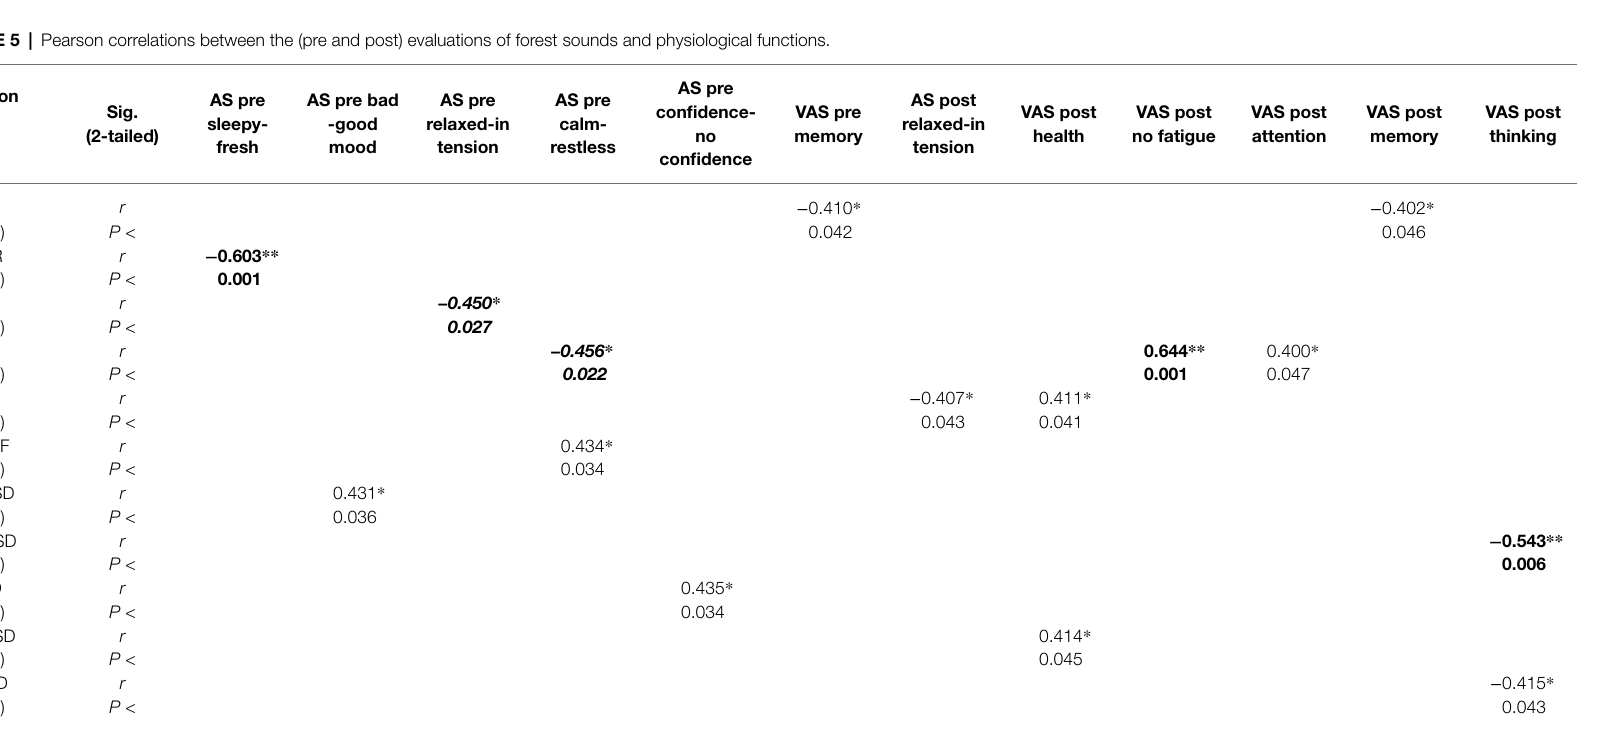
* Bold italics are used to highlight correlations of medium importance (p < 0.028). The least important correlations that are significant at a level of 0.03–0.05 (2-tailed) are in standard font. ** Highlight all the most important correlations that are significant at a level of 0.001–0.010 (two